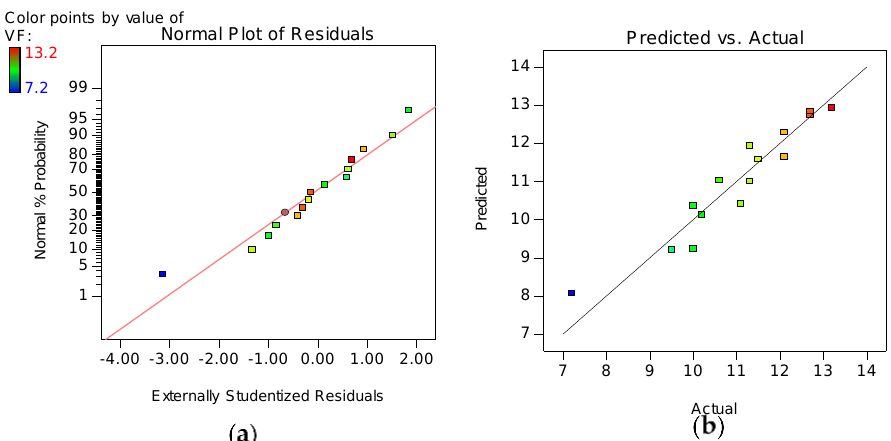
Figure 14. ( a ) Normal plot of residuals and ( b ) Actual vs. Predicted plot for VF.